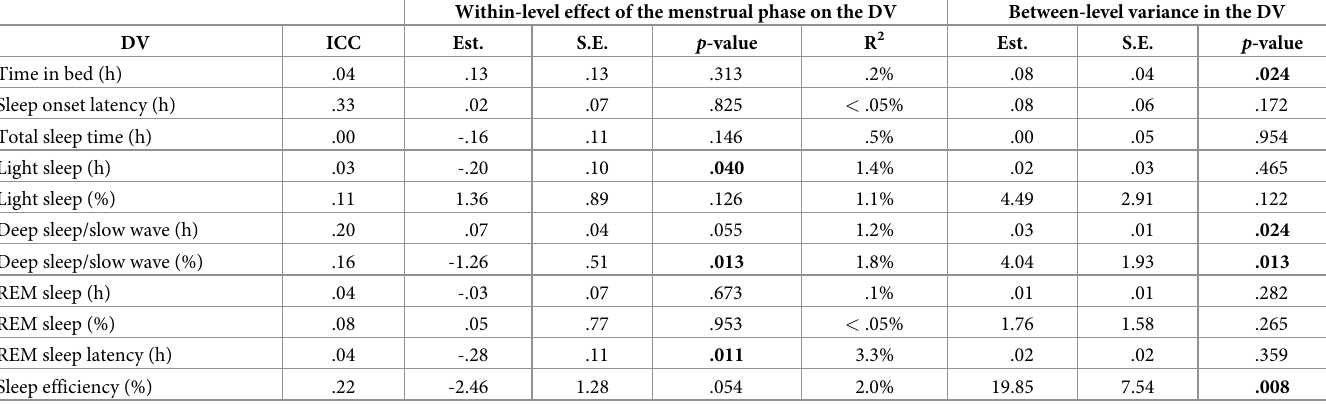
Table 4. Two-level random intercept regressions investigating the effect of menstrual (= 1) vs. pre-menstrual (= 0) phase on sleep variables, based on menstrual cycles recorded in 15 female endurance athletes.